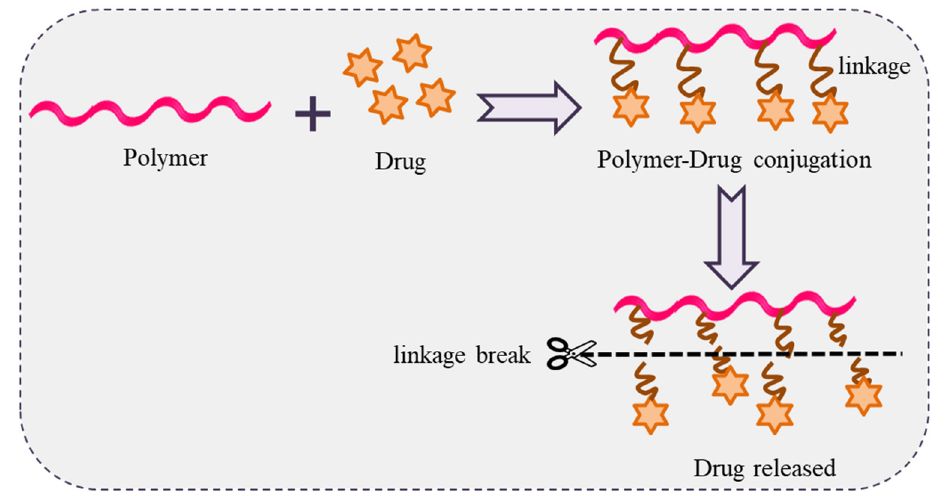
Figure 13. Schematic representation of polymer-drug conjugation with drug release.